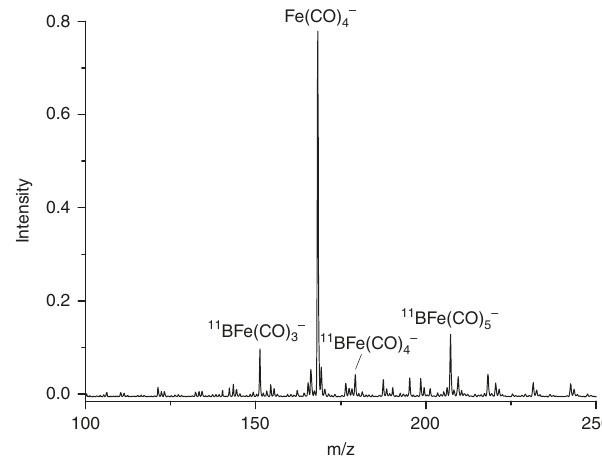
Fig. 1 Mass spectrum of the boron-iron carbonyl anion complexes. The complexes are formed by pulsed laser vaporization of a boron-10 depleted target in an expansion of helium seeded by 7% carbon monoxide with trace of iron carbonyl